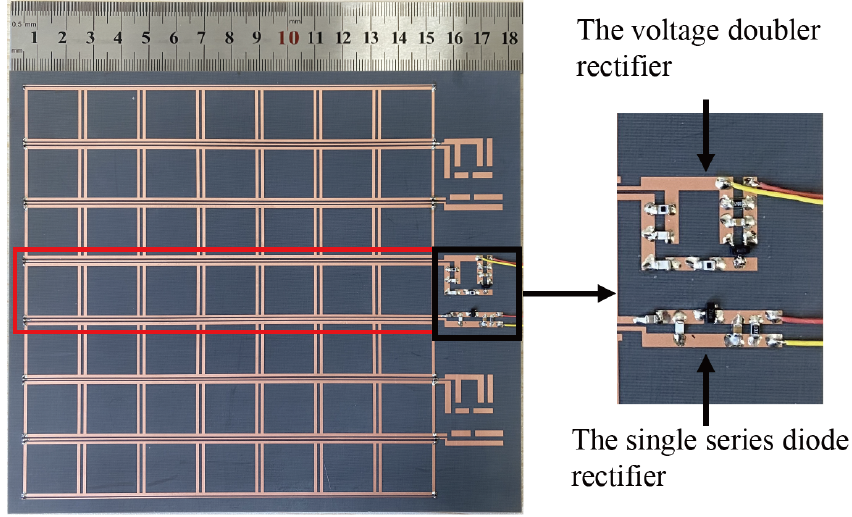
Figure 10. Simulated rectification efficiency curves versus load resistance for the single series diode rectifier and the voltage doubler rectifier.